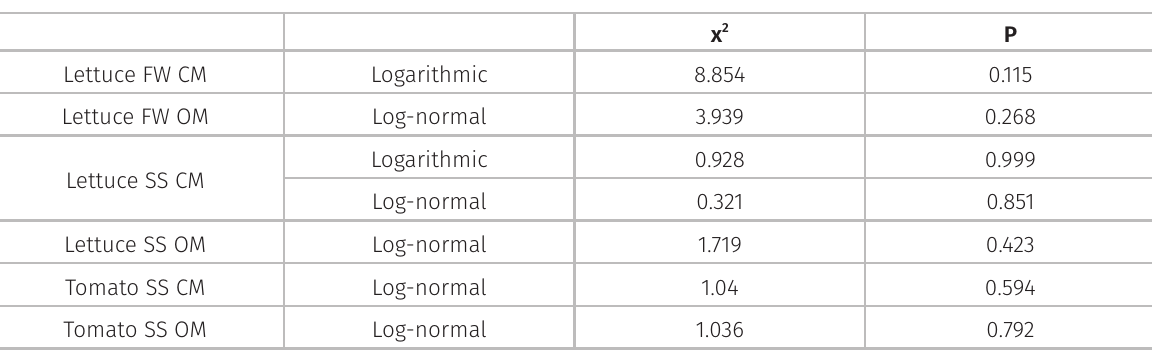
Table IV. Values of probability and goodness of fit tests to distribution models of abundance logarithmic and log-normal for the species of Curculionidae, Carabidae, Staphylinidae and Coccinellidae conforming epigeic coleopteran assemblages in lettuce and tomato crops, in Northern Buenos Aires province, Argentina. Years: 2010-2013.